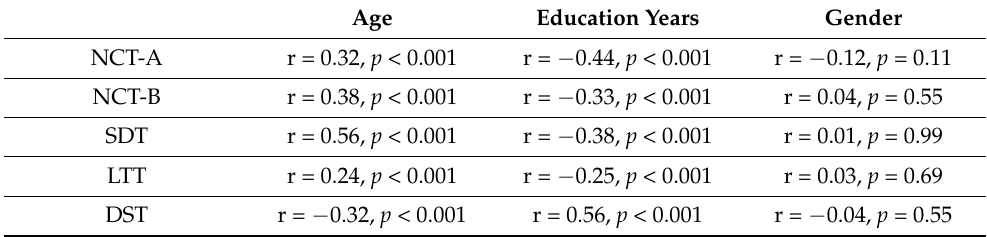
Table 2. Correlation between the results of PHES and studied factors in healthy subjects.